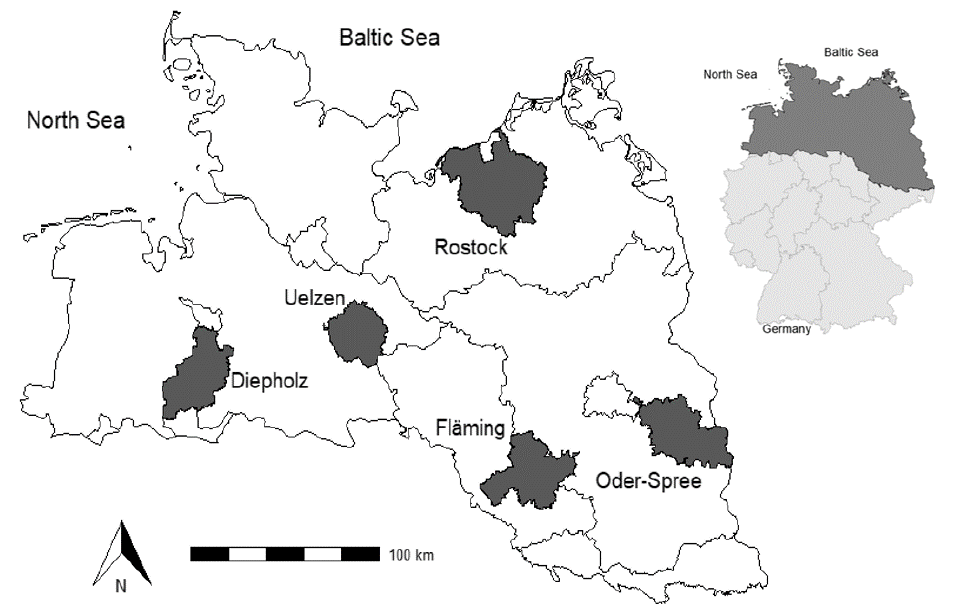
Figure 1. Locations of the five regions of Diepholz, Uelzen, Rostock, Fläming and Oder-Spree in northern Germany. Table 1. Characteristics of the study regions of Diepholz, Uelzen, Rostock, Fläming and Oder-Spree. Average soil and climate parameters (1981–2010). The soil index (‘Ackerzahl’ in German) takes into account the soil quality and other